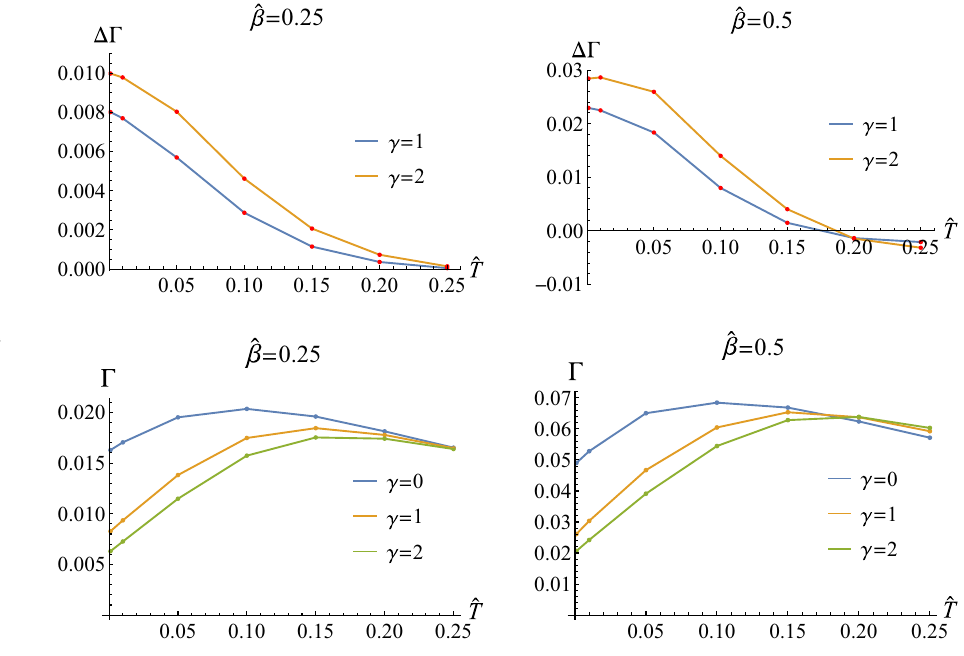
Fig. 9 (cid:19)(cid:18) as the function of the temperature ˆ T with different ˆ β (left plot is for ˆ β = 0 . 25 and right plot for ˆ β = 0 . 5) and γ